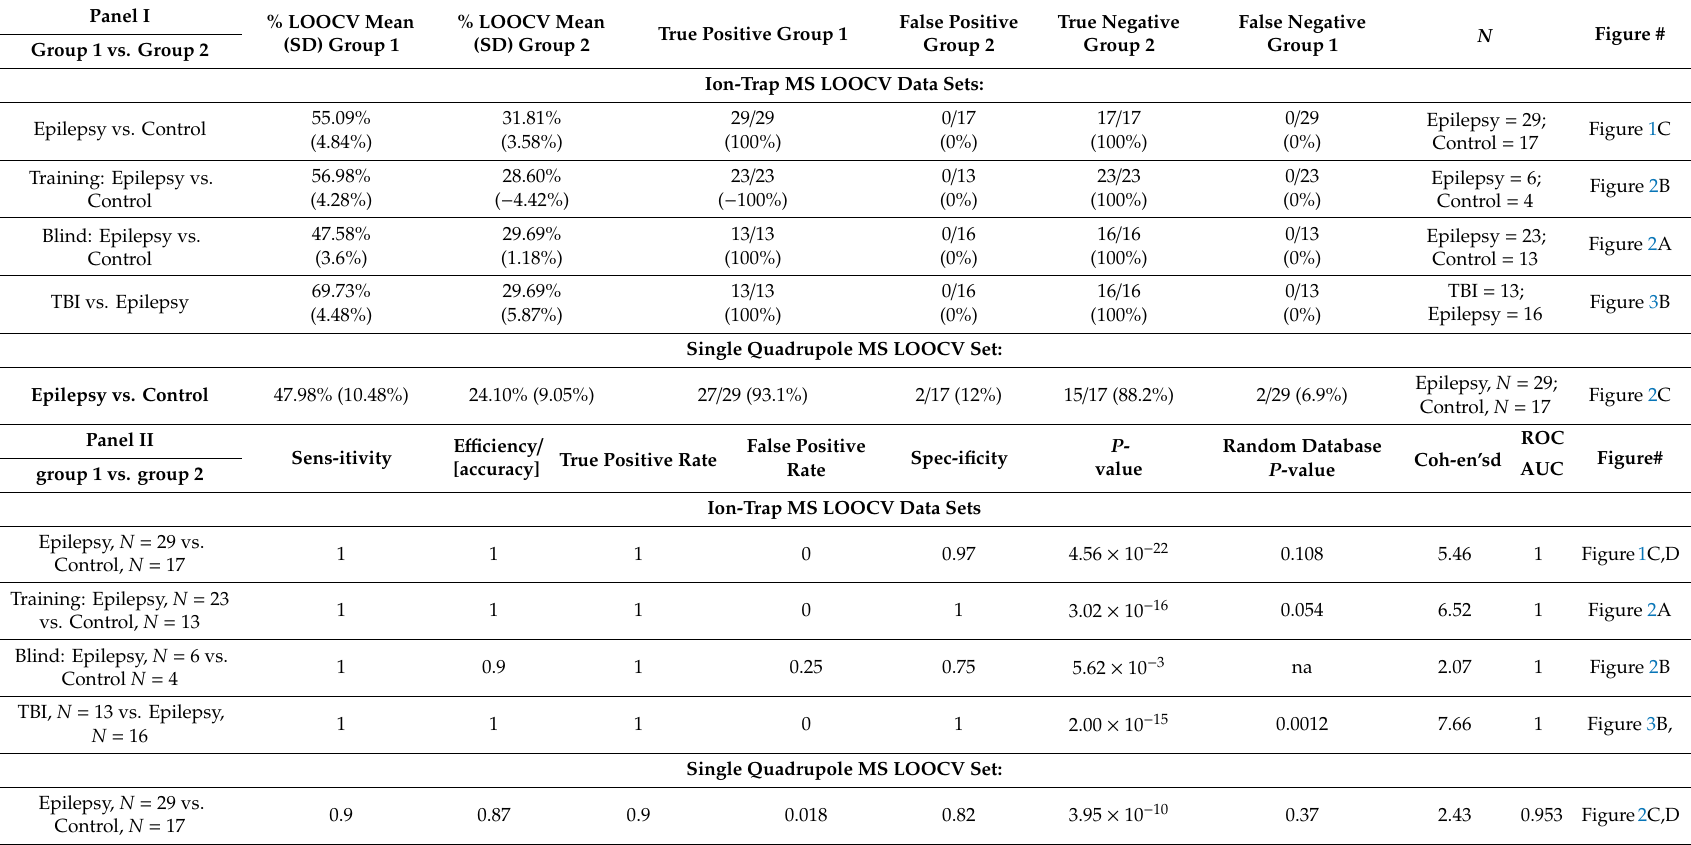
Table 2. Test metrics, patient group epilepsy vs. control